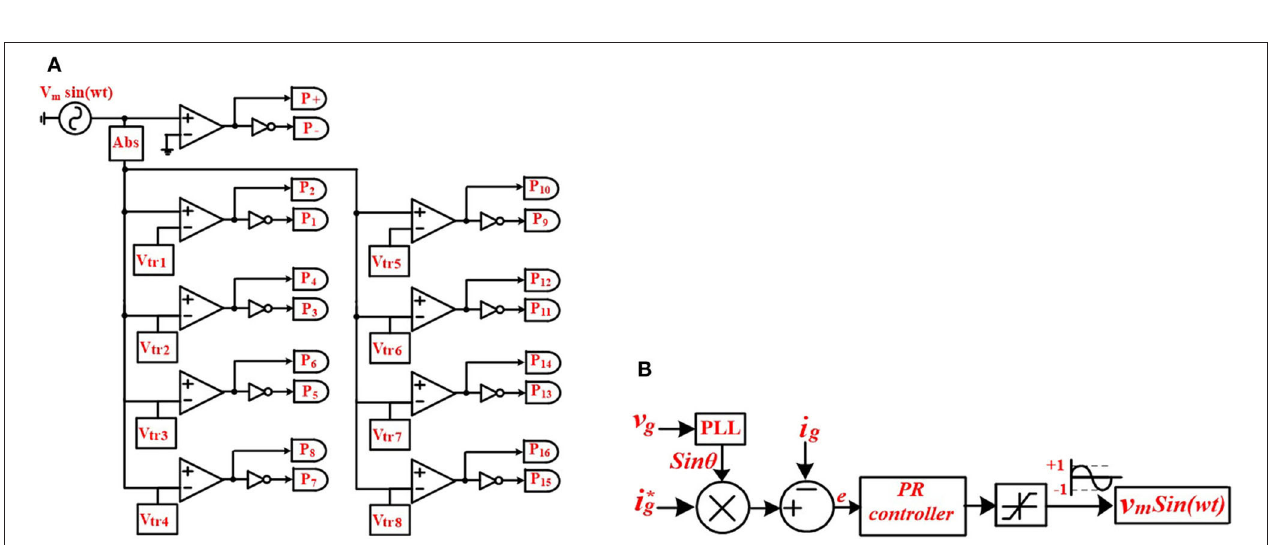
FIGURE 6 | The modulation and control strategies for proposed inverter topology; (A) proposed modulation logic; (B) current control strategy for the grid-connected seventeen level inverter (She et al., 2014).